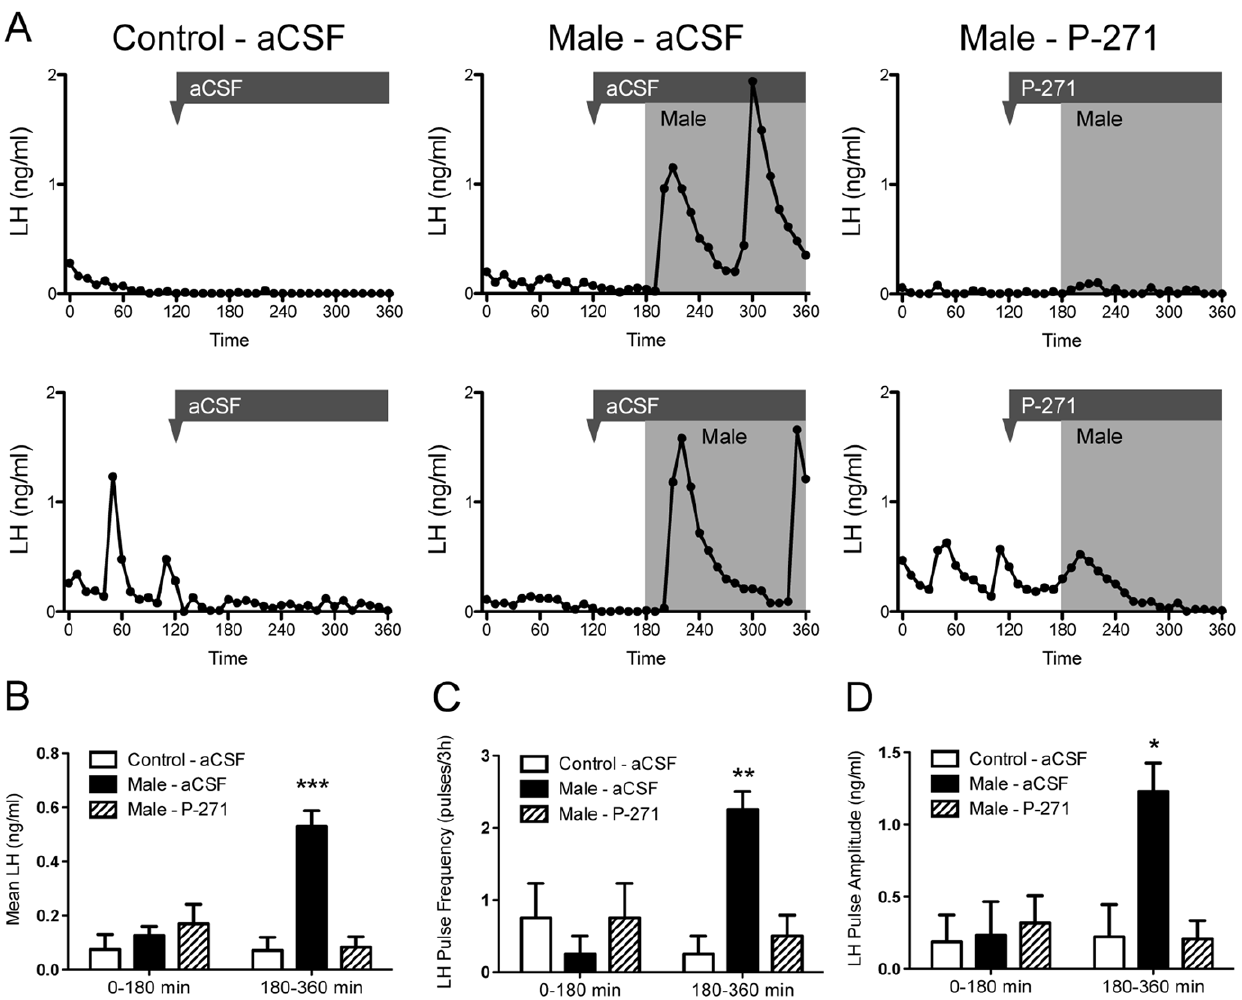
Figure 1. Central infusion of kisspeptin antagonist (P-271) blocks the male effect in anestrous ewes. A, Plasma LH profiles are shown in representative animals treated with artificial cerebrospinal fluid (aCSF) or P-271. The timing of infusion is indicated by the arrowhead/bar, the shaded area indicates male exposure. B–D, Mean LH, LH pulse frequency and pulse amplitude post male exposure. Data are the mean 6 SEM, *P , 0.05, **P , 0.01, ***P , 0.001, n=4 per group.